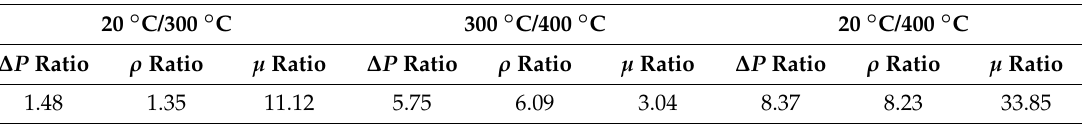
Table 6. Pressure drop, density, and viscosity